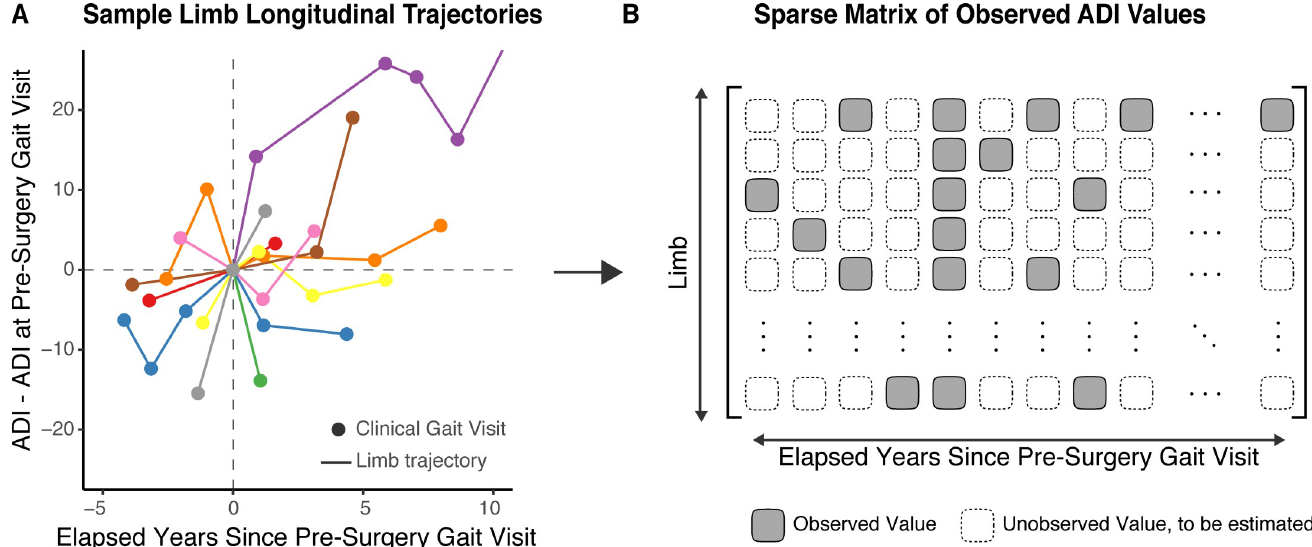
Fig 4. Longitudinal data for long-term analysis. Patients are seen for a gait analysis multiple times throughout their clinical history. (A) The number and frequency of these visits are variable per limb but serve as valuable sparse observations of a limb’s longitudinal development following orthopedic surgery. (B) These observed data can be stored in a sparse matrix. Matrix completion algorithms [23] can be used to estimate the unobserved values by borrowing strength from the available observed values and compute a robust mean patient trajectory following surgical